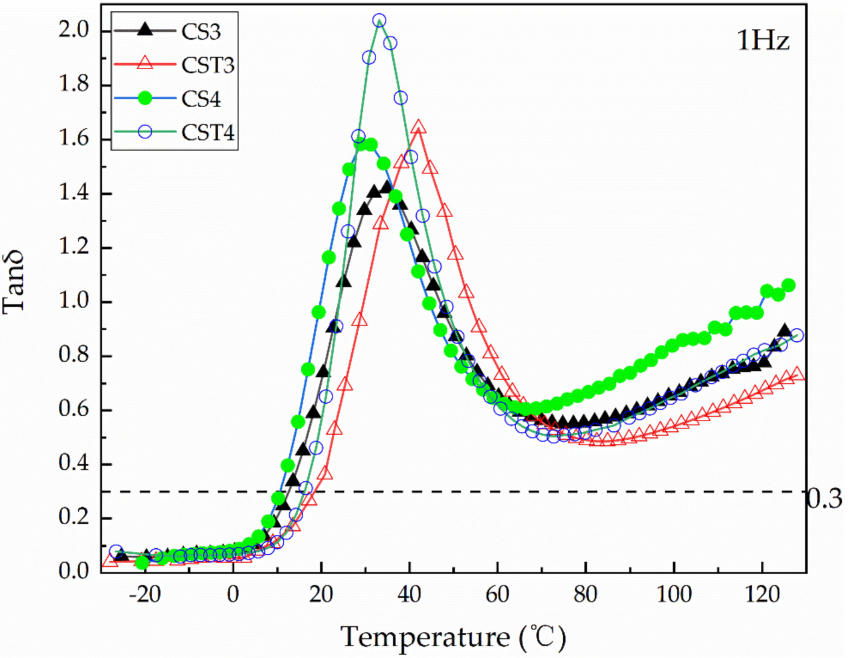
Figure 4. The loss tangent versus temperature curves of CS3, CS4, CST3, and CST4 at 1 Hz. As can be seen from Figure 3, two distinct characteristic peaks appear on the CS1 curve, in which 100.84 ◦ C is attributed to the core polymer of the latex particle, and 6.55 ◦ C is attributed to the shell polymer. The theoretical T g of the core and the shell polymer of CS1 are 96.07 ◦ C and − 13.31 ◦ C, respectively. Similarly, CS2 also shows a similar curve to CS1, while both peaks (74.83 ◦ C and 16.84 ◦ C) are closer to each other, and the curve between both peaks show a platform structure. On the curves of CST1 and CST2, the same phenomenon